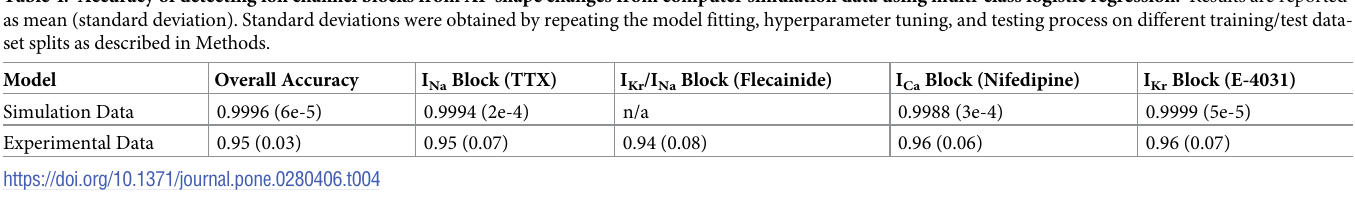
and experimental data in the same plot). TTX (purple) and flecainide (green) are clearly sepa- rated along the PCA1 axis signifying APD prolongation (left and middle scatter plot of Fig 8E) while flecainide (green) and E4031 (blue) are separated along the PCA axis 2 associated with AP upstroke rise time. These two PCA axes explain most of the variance from drug effect (52% and 25% variance by PCA axis 1 and PCA axis 2 respectively for experimental data (Table 3) 79% and 18% variance by PCA axis 1 and PCA axis 2 respectively for simulation data (Table 2)). PCA axis 3 for the experimental data explains minor variance (16%) (right scatter plot of (Fig 8E)); the contribution of PCA axis 3 was insignificant (3%) for the simulation data. The multi-class logistic regression model was 96% (Table 4) accurate at using the AP met- rics to predict which one of the four pharmacological blockers had been applied to the micro- tissues. For the simulation data, the performance of the multi-class logistic regression model in